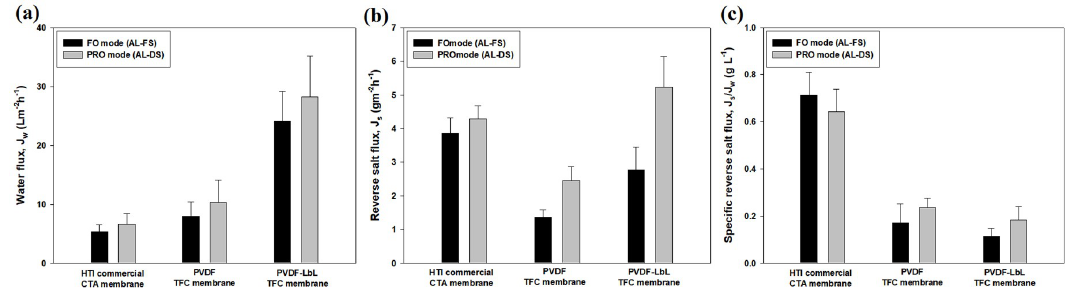
Figure 6. Membrane performance for FO operation of the ( a ) PVDF TFC membrane; ( b ) PVDF-LbL TFC membrane; and ( c ) commercial CTA membrane at FO (AL-FS, i.e., active layer facing the feed solution) and PRO (AL-DS, i.e., active layer facing the draw solution) modes with 0.5 M NaCl and DI water as the draw and feed solutions, respectively.